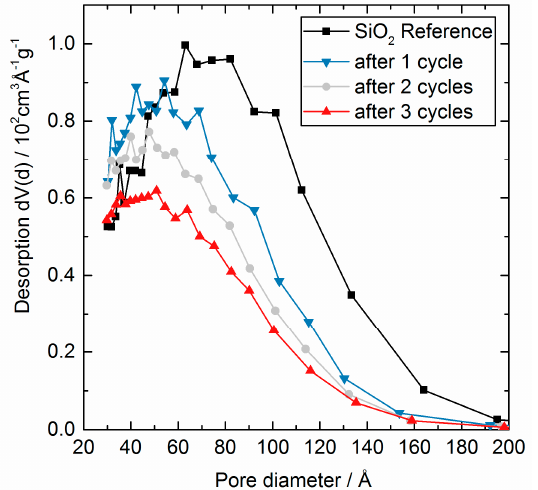
Figure 3. Differential pore volume distribution determined by N 2 desorption, calculated applying BJH theory for SiO 2 coated with AlO x via ALD using TMA and H 2 O at 200 °C. Shown are the graphs for reference SiO 2 (black, ■ ), after 1 cycle (blue, ▼ ), after 2 cycles (grey, ● ), and after 3 cycles (red, ▲ ). All samples gave an H 1 type hysteresis loop, with parallel adsorption and desorption